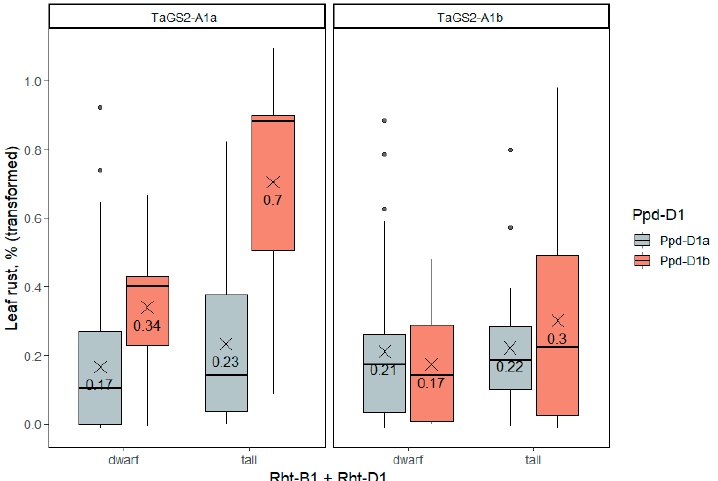
Figure 6. Leaf area damaged by brown rust in winter wheat accessions differing in Rht-1 , Ppd-D1 and TaGS2-A1 genotypes, proportion transformed with arcsin ( √ x ). The dots indicate outliers.